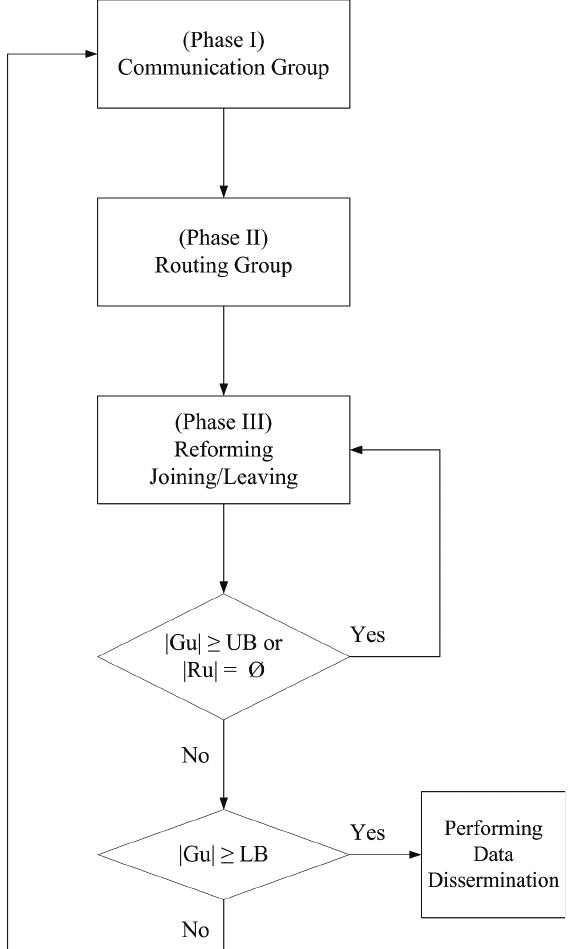
Figure 2. Flow diagram of the hybrid distributed topology control (HDTC) scheme. UB, upper bound; LB, lower